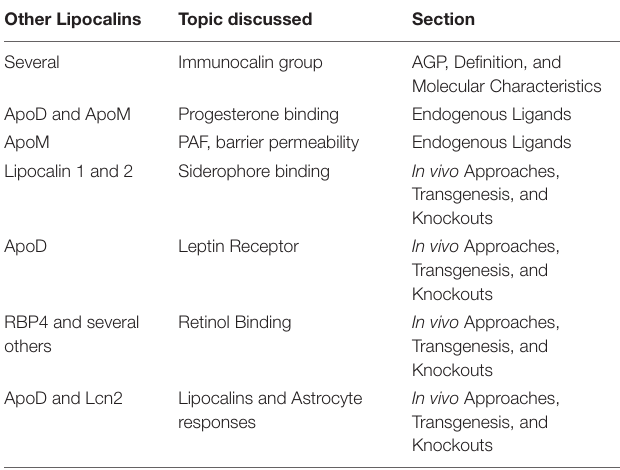
TABLE 1 | Summary of the associations/common features of AGP and other members of the Lipocalin protein family discussed in this mini-review. Note many other examples might